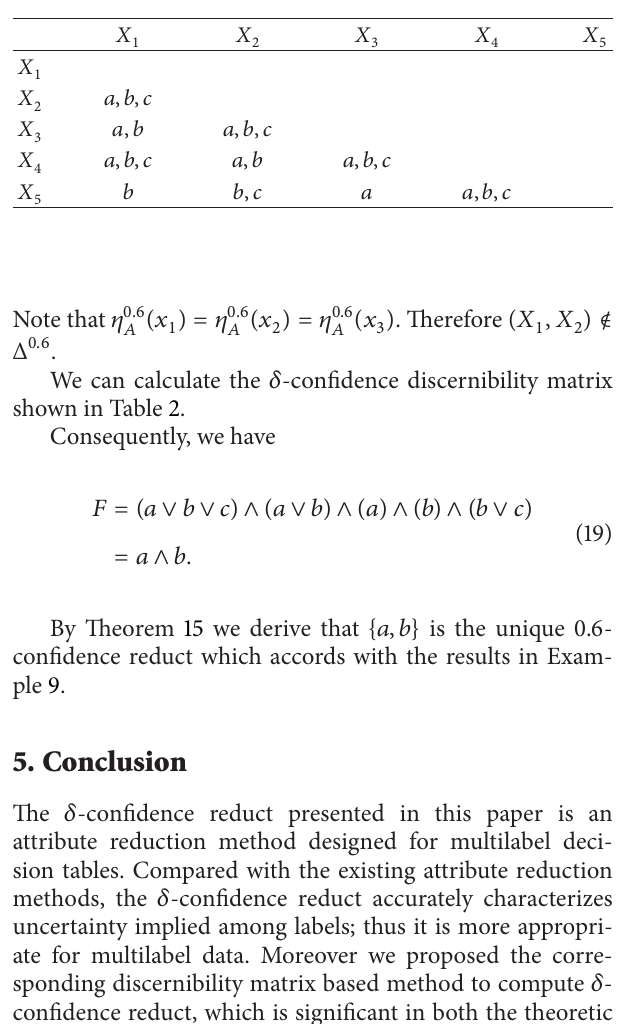
Table 2: The 𝛿 -confidence discernibility matrix M